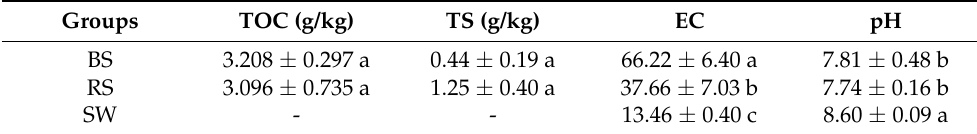
Table 1. Changes in the environmental factors among the BS, RS, and SW groups.